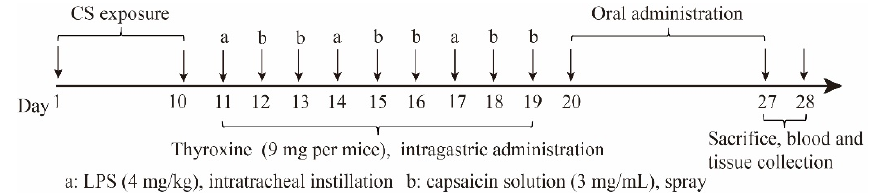
Figure 7. Schematic protocol for establishing the PIC model and the treatment schedule.